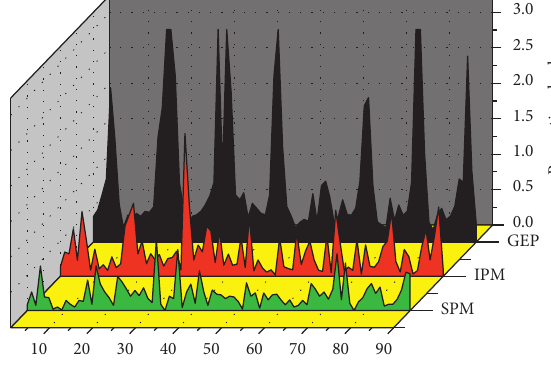
Figure 9: GEP-IPM-SPM mean error. Table 4: Sunspot GEP-IPM-SPM comparative test data conclusion.